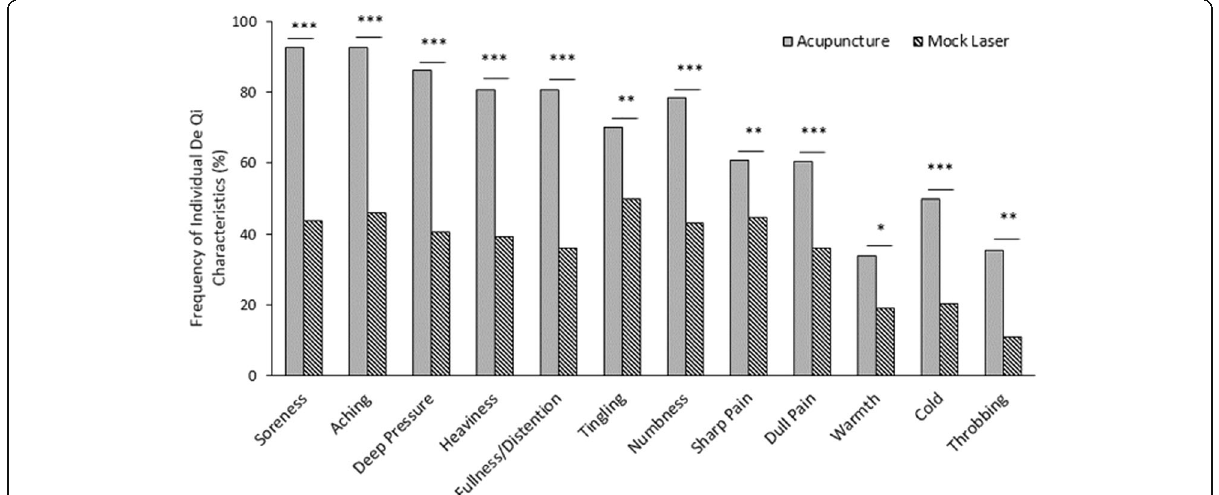
Fig. 5 Comparison of the frequency of individual De Qi psychophysical responses during acupuncture and mock laser intervention. Data for weeks were pooled together. Frequencies calculated upon the number of participants reporting perceptions within each study arm ( n = 47 for the acupuncture group, n = 37 for the mock laser group). Data related to mock laser group (Centre 3) was excluded from data analysis. Each De Qi characteristic was shown on a Likert scale rating (0-10); In all cases the expected frequencies were less than five in each cell and therefore Fisher Exact test was used, * p < 0.05, ** p < 0.01, *** p <